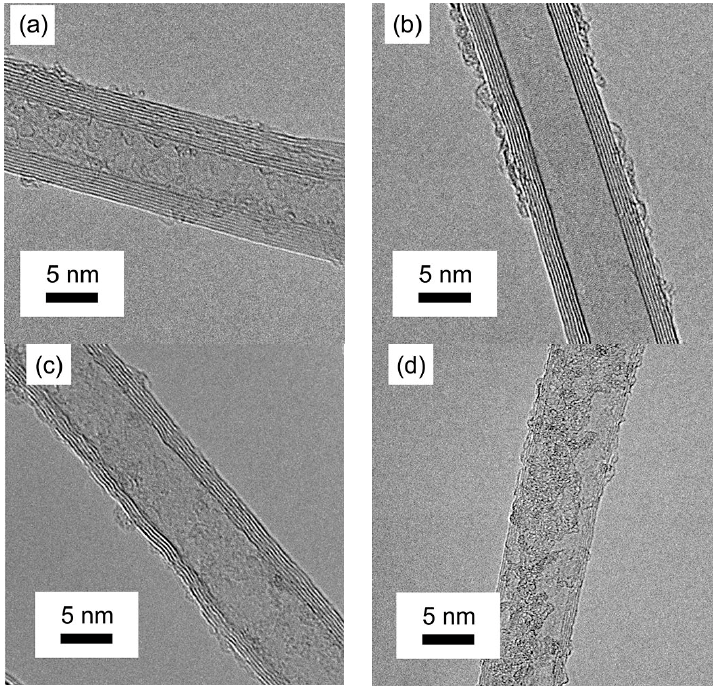
Figure 3. TEM images of single VACNTs prepared under different H 2 concentrations: ( a ) 5%; ( b ) 15%; ( c ) 25%; ( d ) 35%.